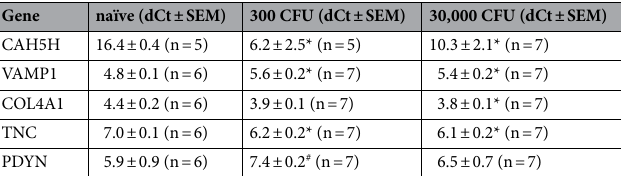
Table 3. Quantitative PCR analysis of a sample of differentially-expressed genes. p < 0.05 versus